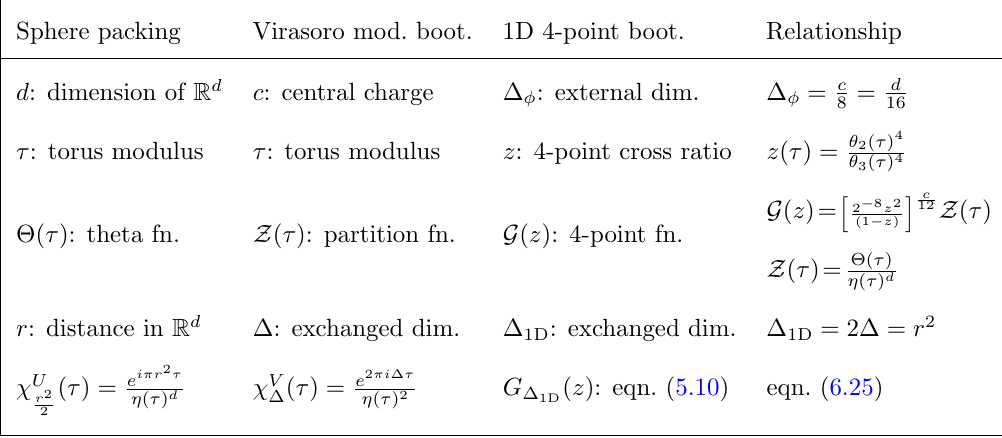
Table 1 . Dictionary relating the bounds on sphere packing, the Virasoro modular bootstrap and the four-point function bootstrap on a